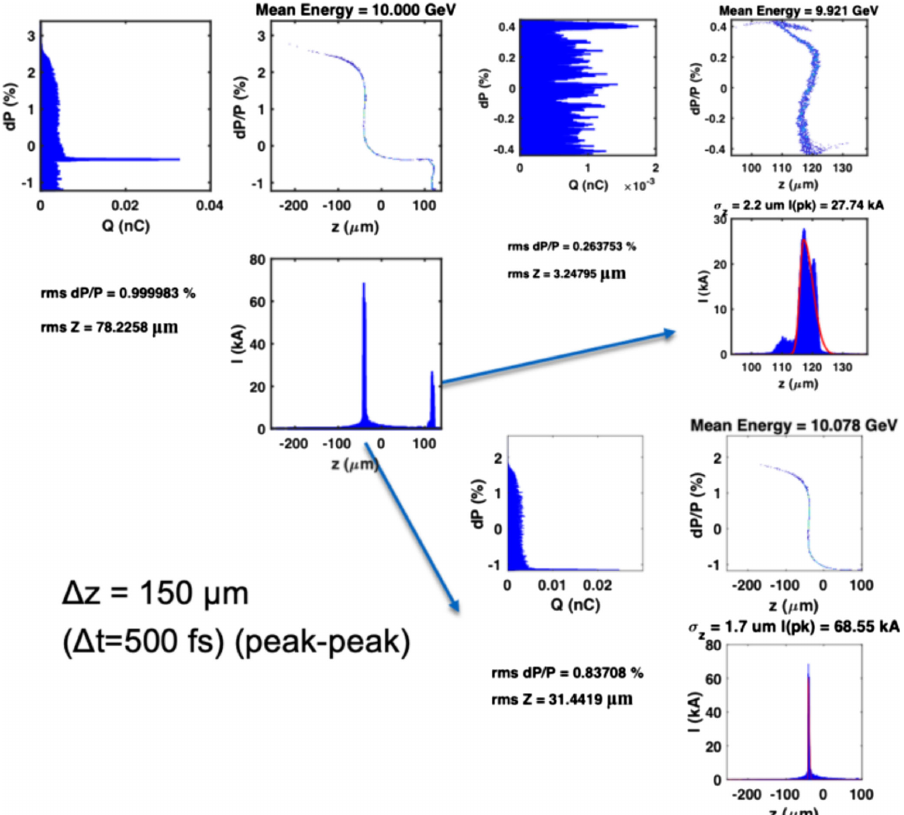
FIG. 8. Longitudinal phase space at sector 20 interaction point for the two-bunch configuration. From the tracking simulation.